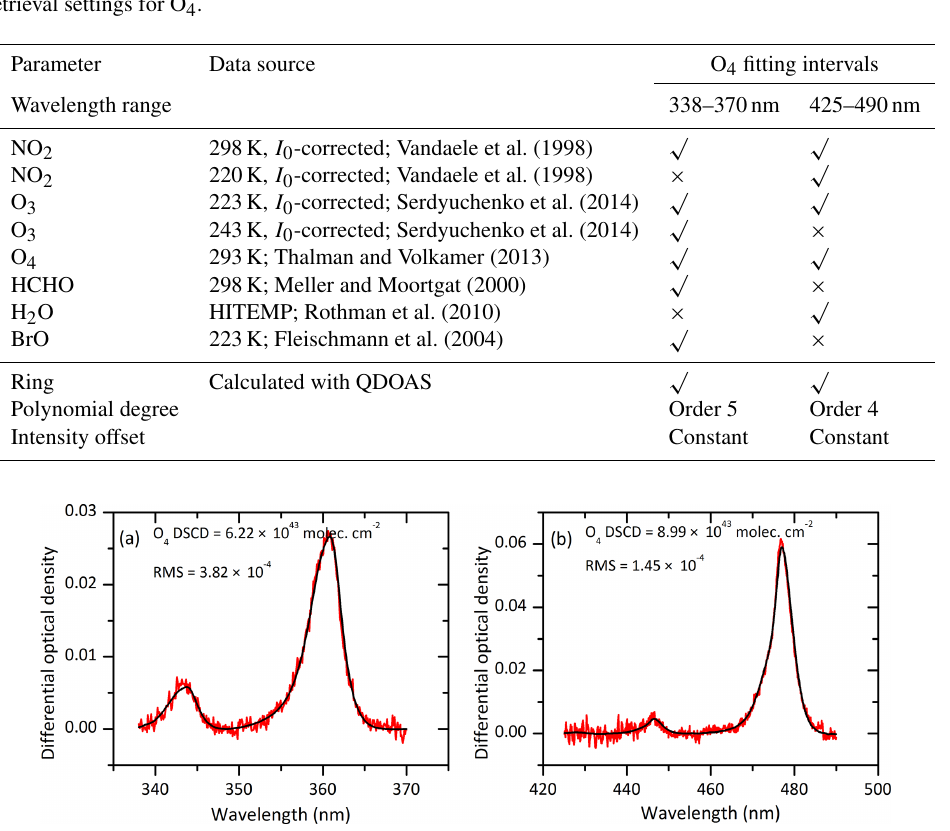
Table 1. DOAS retrieval settings for O 4 .